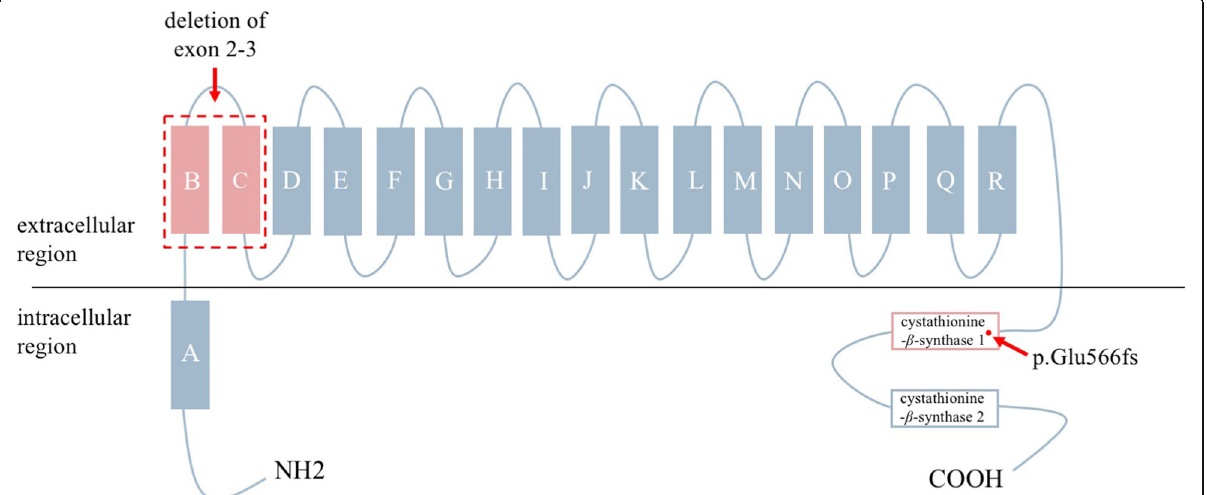
Fig. 3 The schematic figure of the ClC-Kb protein. ClC-Kb is a transmembrane protein consisting of 18 α -helices (A to R) and 2 cystathionine- β - synthase domains. The α -helices involved in the selectivity filter, those interacting with Barttin, and those located at the dimer interface. The mutation of the deletion of exon 2 – 3 is located in α -helix B and C of ClC-Kb, involved in the dimer interface; and p. Glu566fs is located in the cystathionine- β -synthase 1 domain involved in channel common gating and trafficking. These mutations were predicted to result in the production of unstable mRNAs or truncated or absent